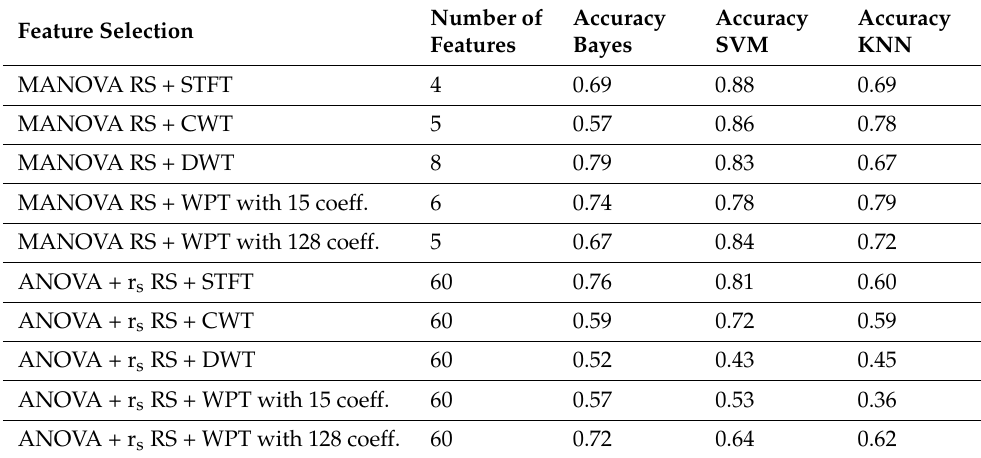
Table 7. Classification model evaluations for OTE classification.